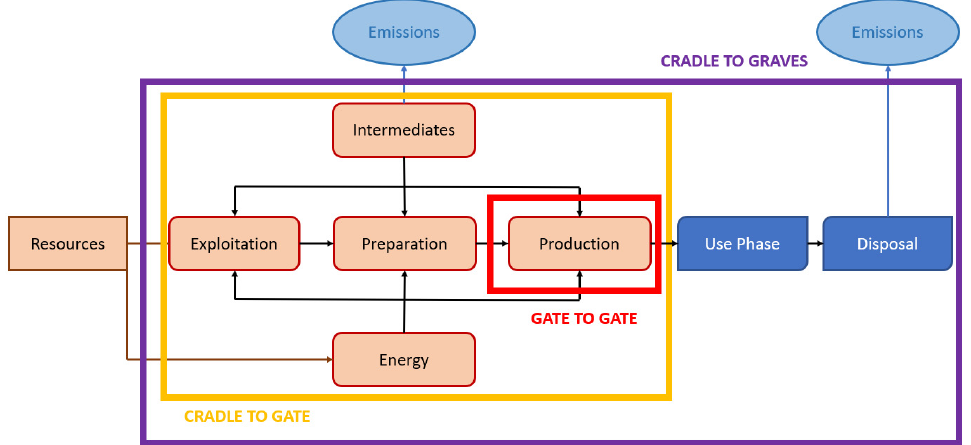
Figure 1. General system boundaries scheme for life-cycle assessment (LCA) studies. In this study, two different fuel cell types are considered.